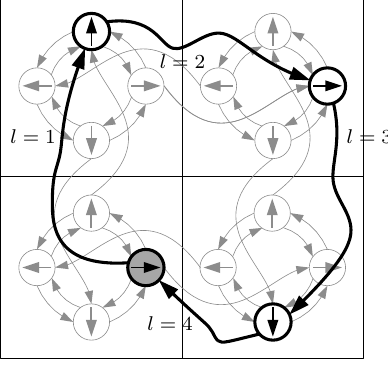
Figure 4. An example of a solution to a problem instance. Configurations in the solution are represented by thick circles and the shortest paths between them by thick lines. Each path between two consecutive candidate sensing configurations in the solution is annotated with a label variable l , and the marked configuration corresponds to the special